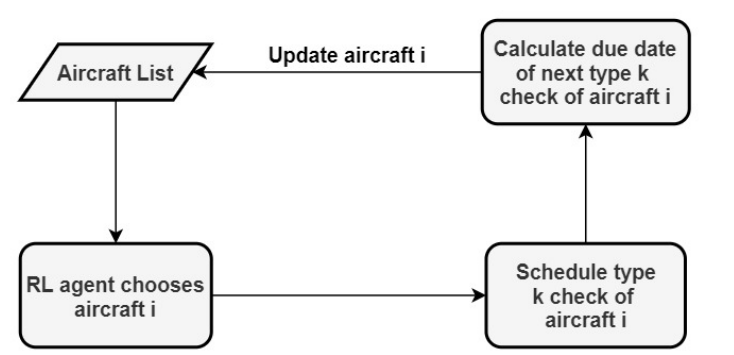
Figure 2. General workflow of the check scheduling process.